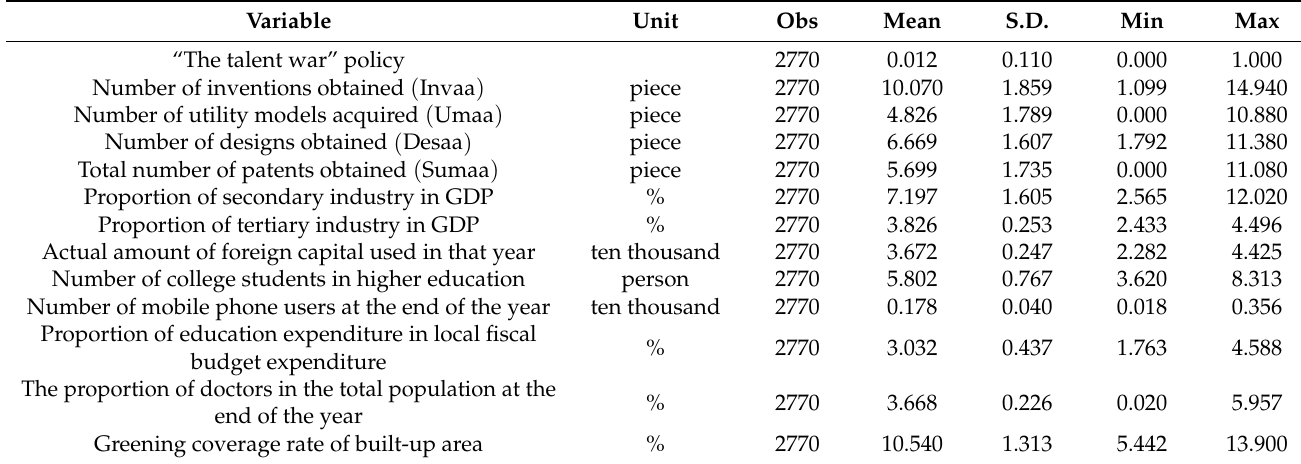
Table 2. Descriptive statistical results of variables.